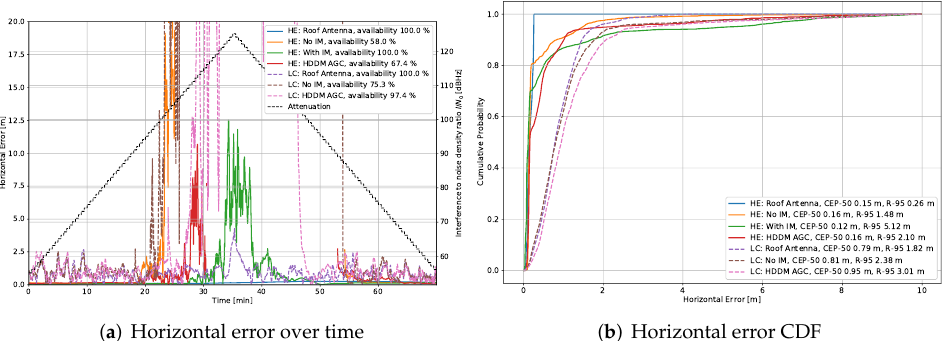
Figure A23. Interference #5: Slow frequency hopper with a dwell time of 100us and a frequency range of 35MHz.